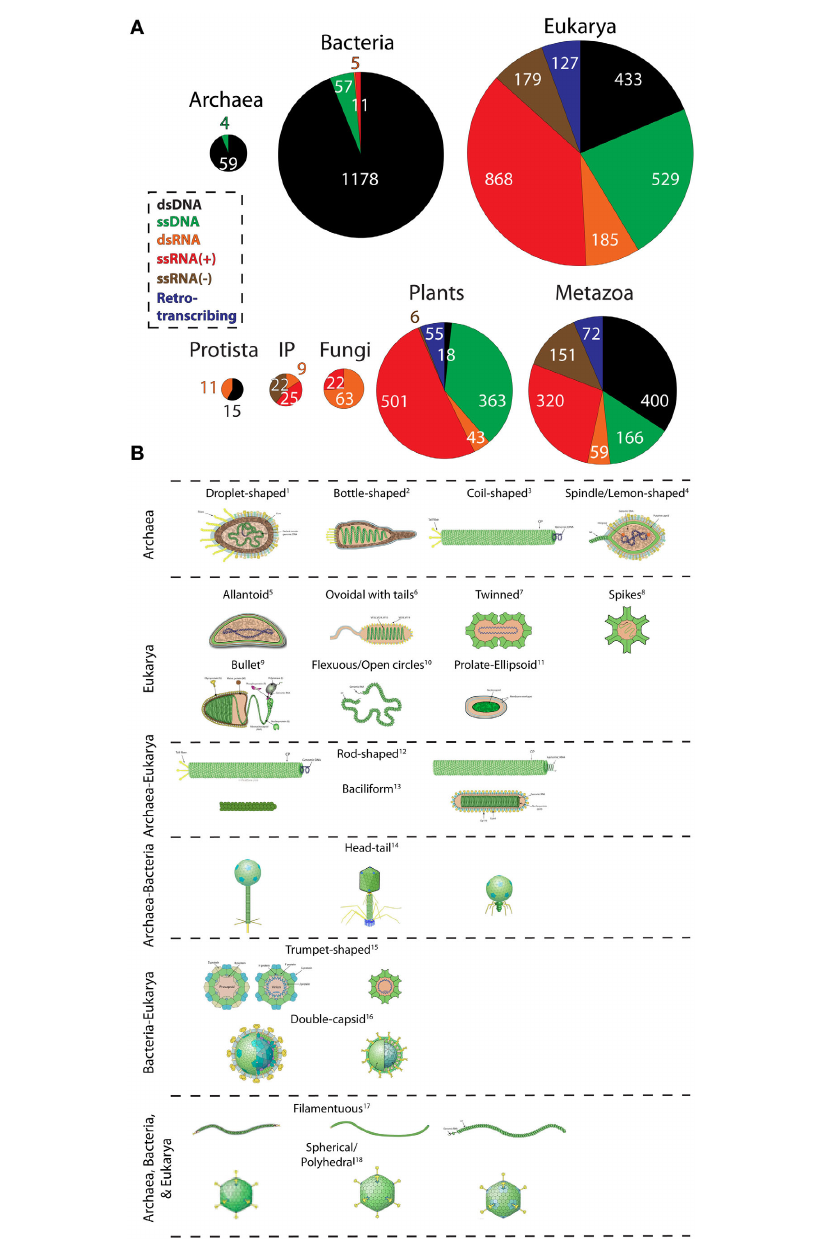
FIGURE 1 | The abundance and diversity of viral lineages in the domains of life. (A) Pie-charts describe the abundance of dsDNA, ssDNA, dsRNA, ssRNA( + ), ssRNA( − ), and retrotranscribing viruses in Archaea, Bacteria, and Eukarya, and within the major eukaryal divisions. Genome data from 3660 completely sequenced viral genomes corresponding to 1671 dsDNA, 610 ssDNA, 883 ssRNA( + ), 179 ssRNA( − ), 190 dsRNA, and 127 retrotranscribing viruses were retrieved from the Viral Genomes Resource (April, 2014). Additionally, two ssDNA archaeal viruses were identified from the literature (Pietilä et al., 2009; Mochizuki et al., 2012). Viruses that were unassigned to any order, genera, or species and unclassified viruses were excluded from sampling. Viruses were broadly classified according to host preferences into the following categories: Archaea, Bacteria, Protista (animal-like protists and brown algae), Invertebrates and plants (IP); Fungi (all fungi and fungi-like protists); Plants (all plants, green algae, and diatoms), and Metazoa (vertebrates, invertebrates, and human). Host information was available for roughly 99% (3633) of the sampled viruses. Pie-charts are proportional to the size of each distribution. (B) Virion morphotypes that are specific to a domain or are shared between domains are displayed. Virion pictures were